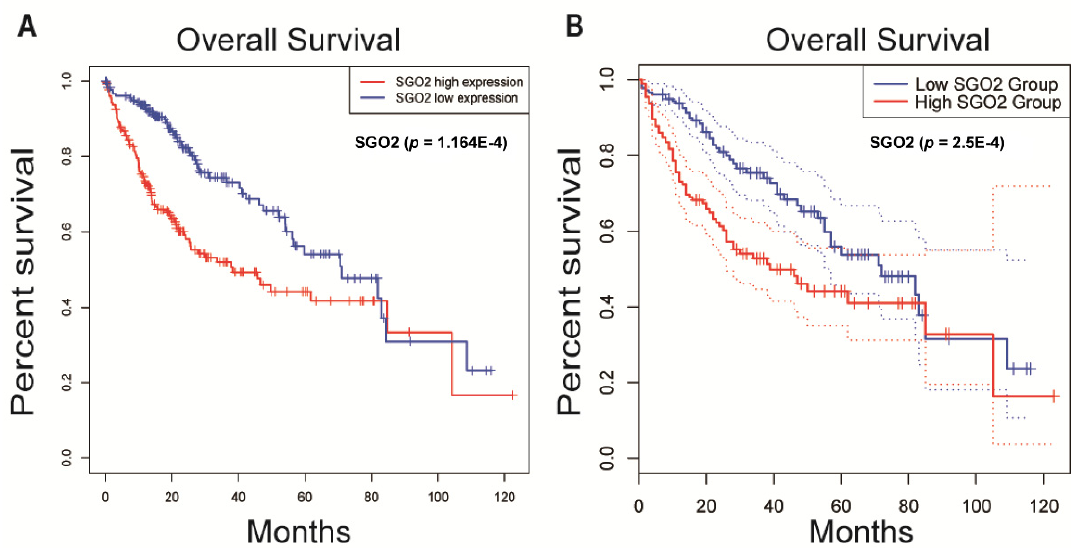
Figure 2. Overall survival of HCC patients grouped by the SGO2 median cutoff in the TCGA ( A ) and GEPIA2 databases ( B ). SGO2, shugoshin 2; TCGA, The Cancer Genome Atlas; GEPIA2, Gene Expression Profiling Interactive Analysis 2; HCC, hepatocellular carcinoma.